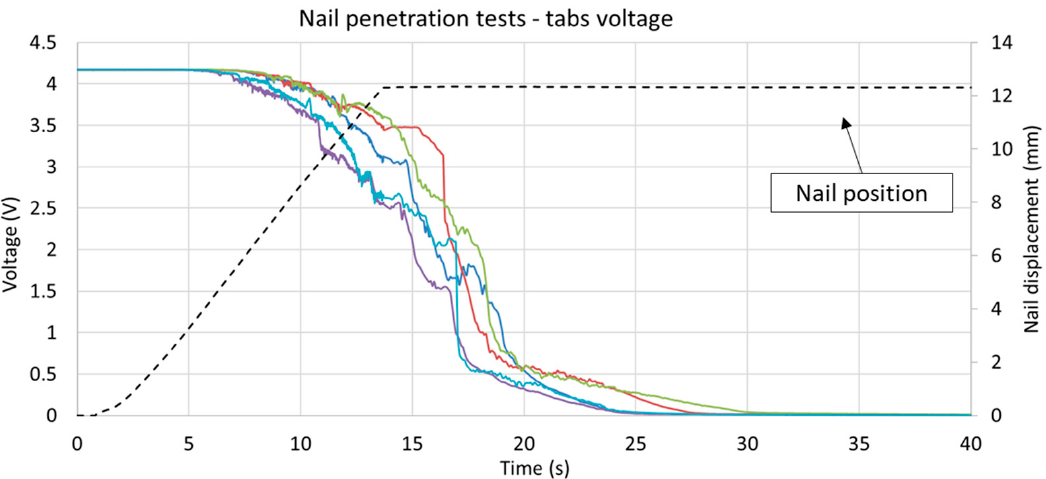
Figure 7. Temperature measurements made in the nail penetration test. The thermocouples numbers and position are described in Figure 5. The temperatures of the anode and cathode tabs increased more rapidly in the initial stage of the test. Thermocouples 6 and 7 registered markedly lower temperatures due to their greater distance from the nail. The ambient temperature was within the range 0–5 °C.